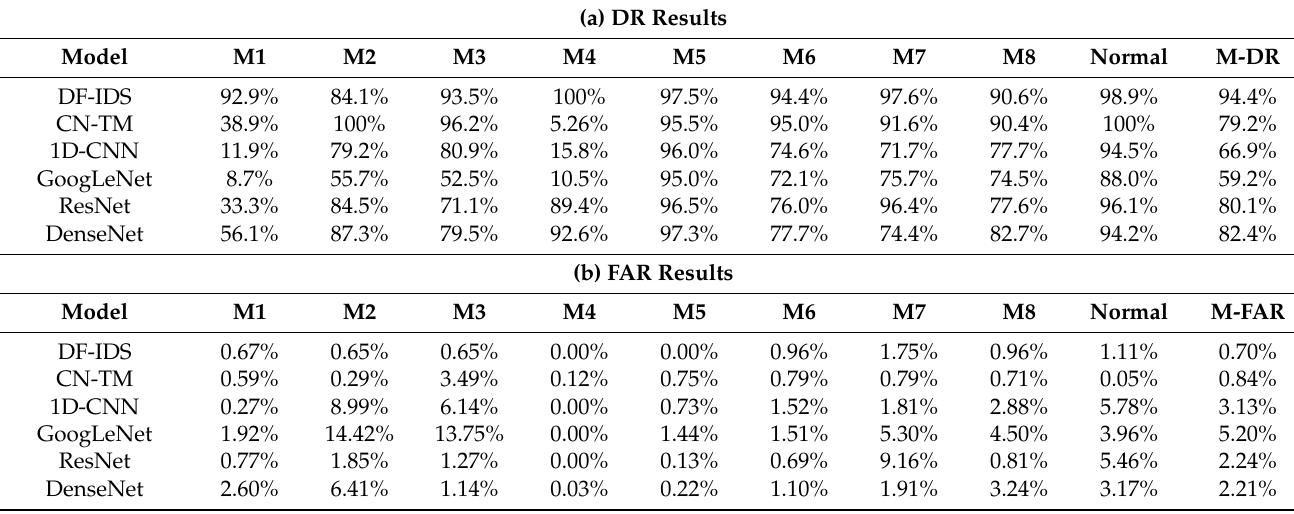
Table 10. Performance of multiclassification model using Dataset 1.